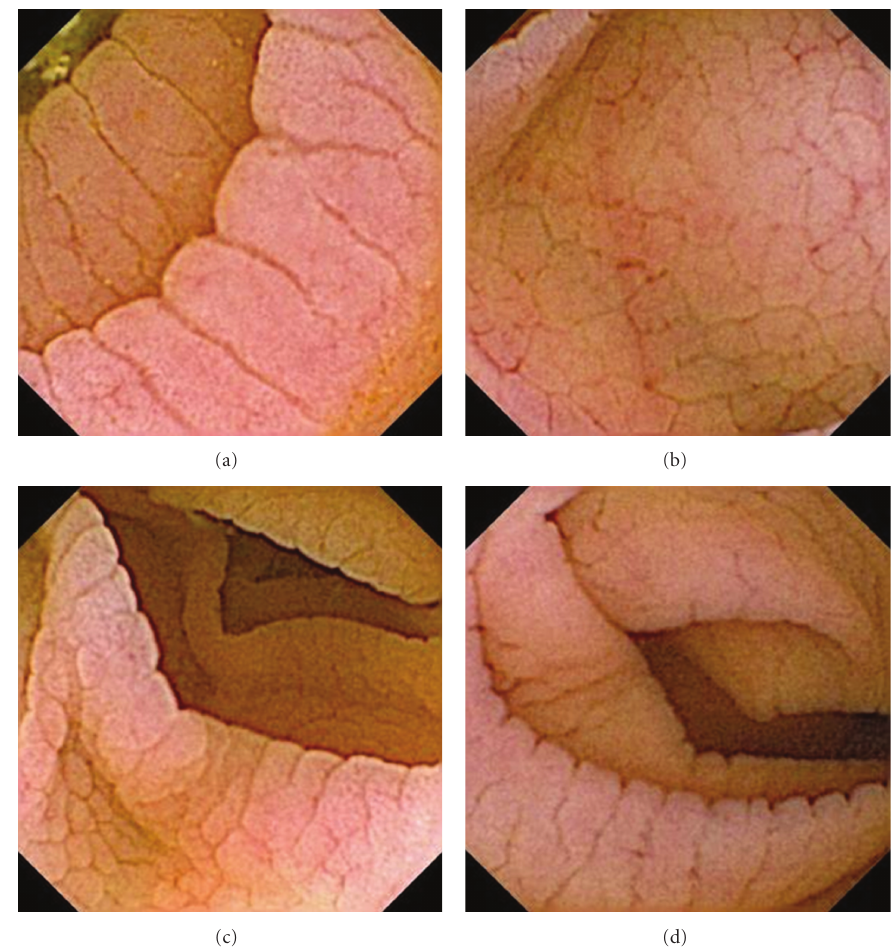
Figure 1: Capsule endoscopy images of celiac disease. (a) scalloping; (b) mosaic pattern; (c) micronodularity; (d) layering of